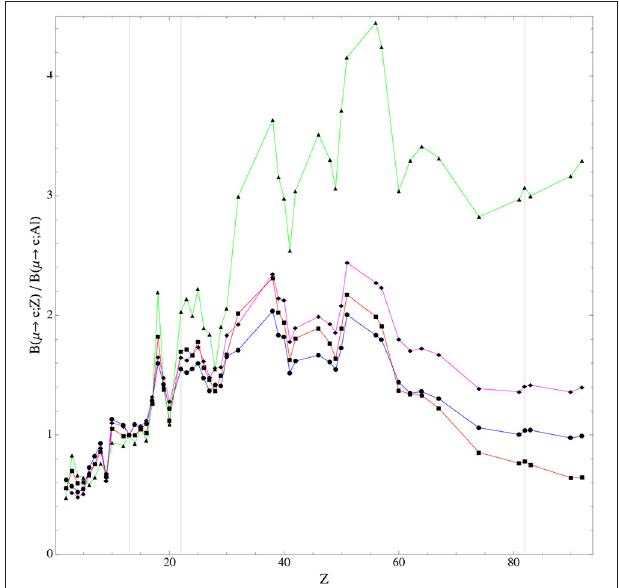
FIGURE 20 | Figure and caption from Cirigliano et al. [44]. Target dependence of the µ → e conversion rate in different single-operator dominance models. We plot the conversion rates normalized to the rate in Aluminum ( Z = 13) vs. the atomic number Z for the four theoretical models described in the text: D (blue), S (red), V ( γ ) (magenta), V ( Z ) (green). The vertical lines correspond to Z = 13(Al), Z = 22(Ti), and Z =